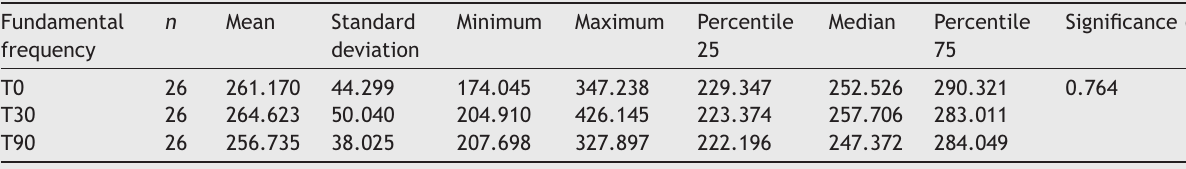
Fundamental frequency --- Vowel /u/.